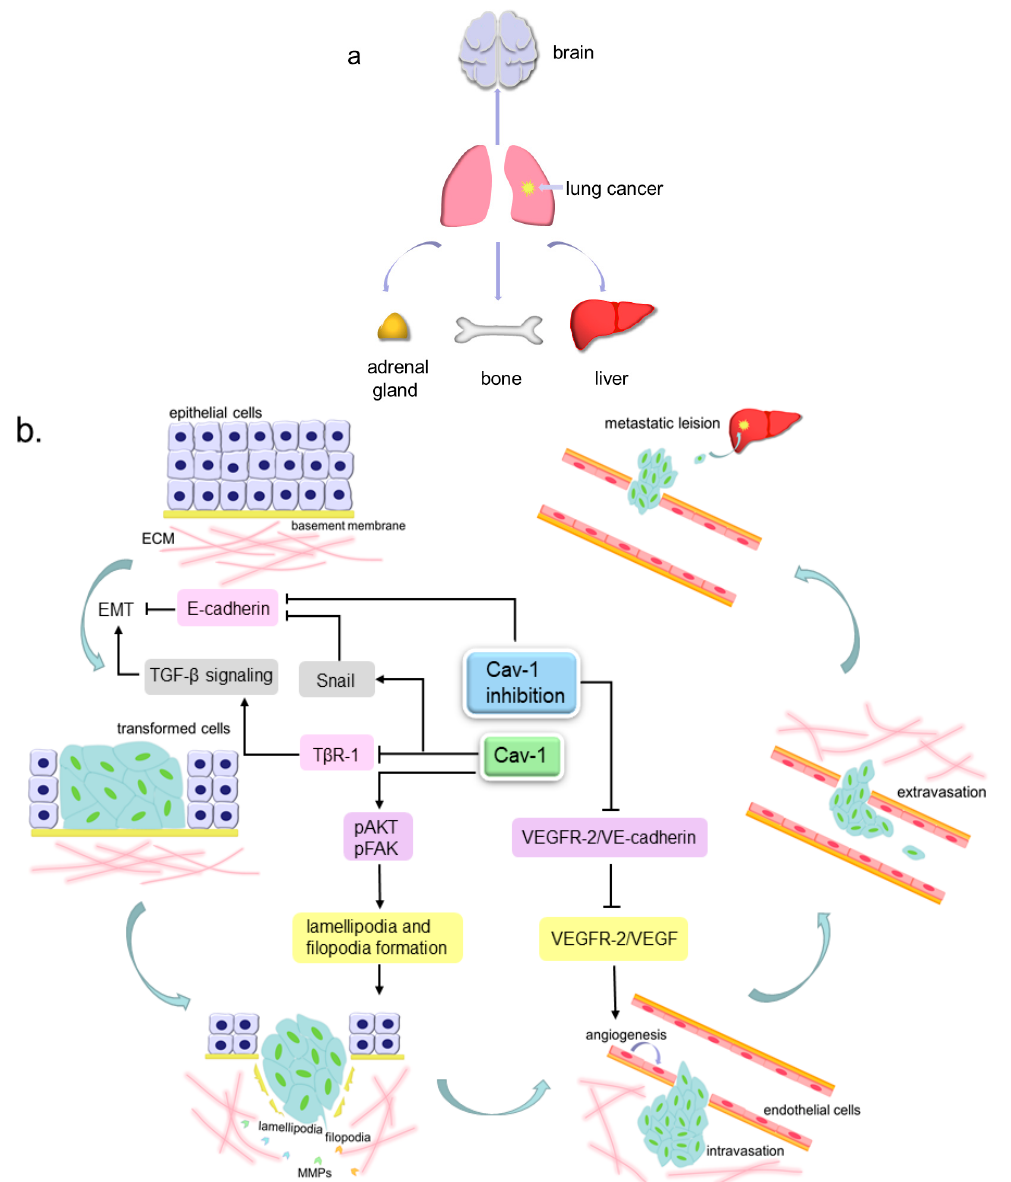
Figure 2. The pattern of lung cancer metastasis. ( a ). The preferential sites of lung cancer metastasis, include brain, liver, bones and adrenal glands; ( b ). Cav-1 participates in lung cancer metastasis. The lung tumor epithelial cells can undergo epithelial to mesenchymal transition (EMT) to become more invasive transformed cells, then invade locally into the stroma by extending motive pseudopods and secreting MMPs to degrade ECM, later intravasate into blood or lymphatic vessels and survive within the circulation, and finally extravasate and generate a metastatic lesion at a distant site. Cav-1 can inhibit TGF- β signaling-mediated EMT via inducing the internalization and degradation of T β R-1. Cav-1 over-expression can increase the Snail level to repress the E-cadherin level, further to facilitate EMT, and can also increase the lamellipodia and filopodia formation by elevating pAKT and pFAK expression, leading to enhanced cell invasiveness. Cav-1 absence can prevent VEGFR-2 from binding VE-cadherin and permits VEGFR-2 to be phosphorylated by VEGF, thus to enhance endothelial cell growth and lead to angiogenesis. Cav-1 knockdown can reduce E-cadherin to attenuate cell adhesion and lead to